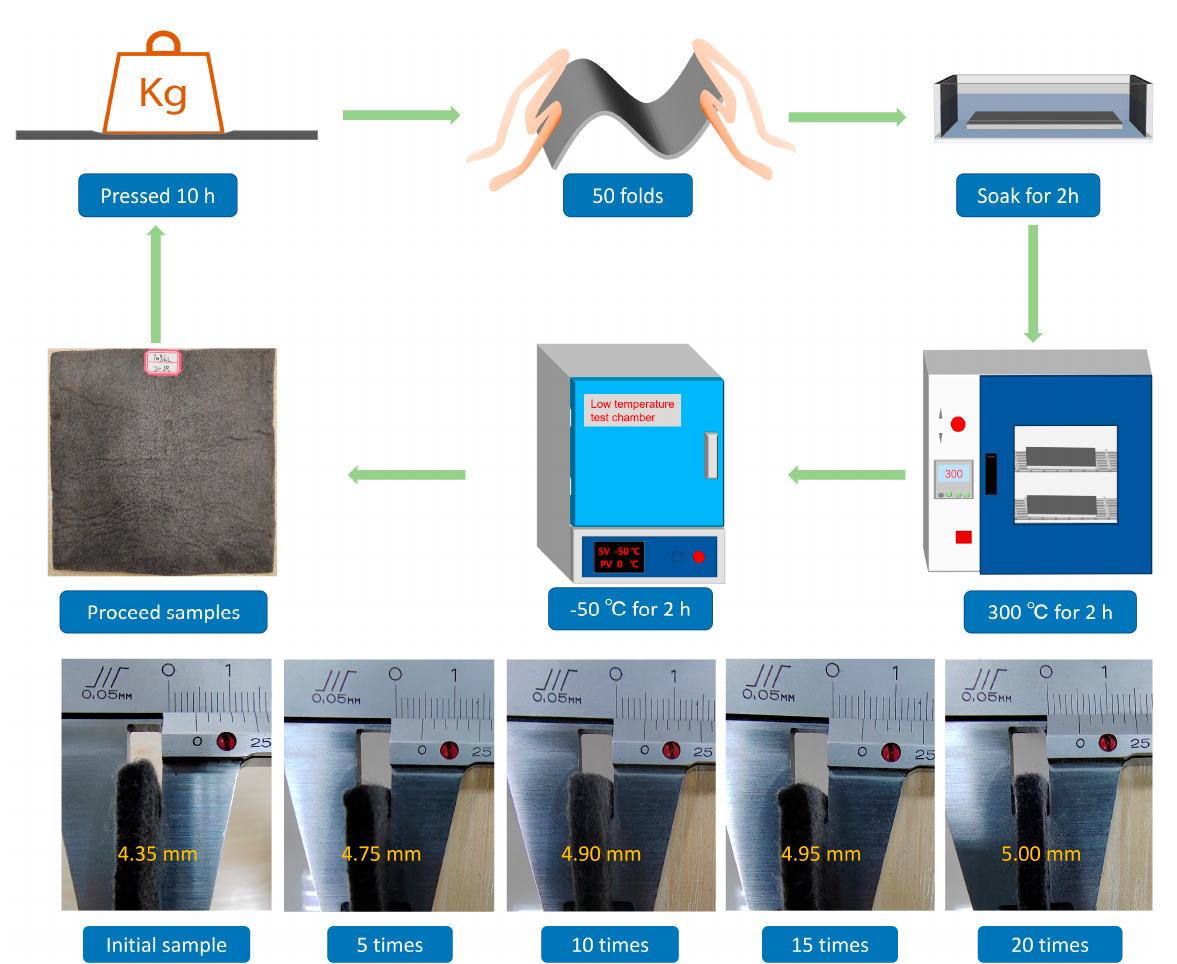
Figure 2. Extreme environmental adaptability test of RGO/NW composites.